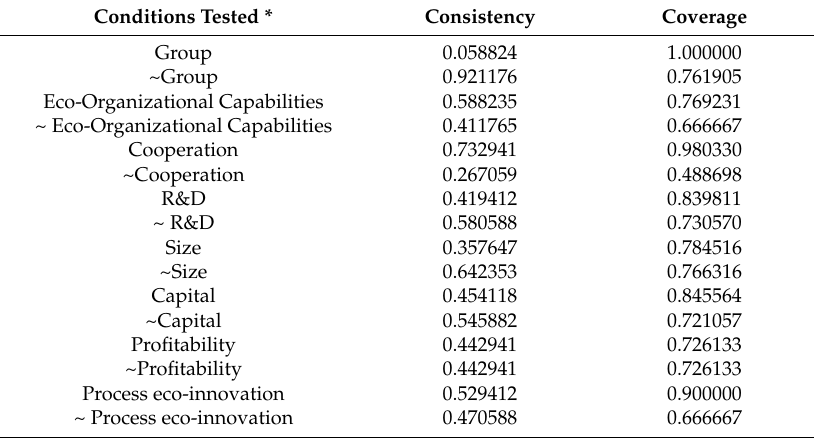
Table 4. Companies developing internal product eco-innovations. Analysis of the necessary conditions.